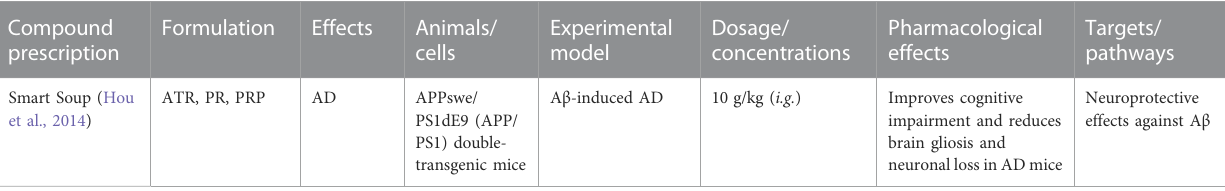
TABLE 7 ( Continued ) Clinical application of compound prescription containing ATR.